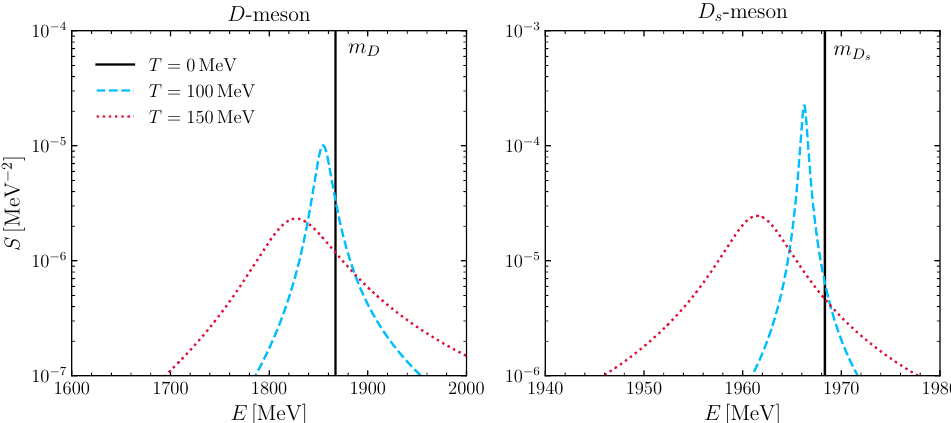
Figure 2: Spectral functions of the D - and D zero momentum and at T = 0, 100,